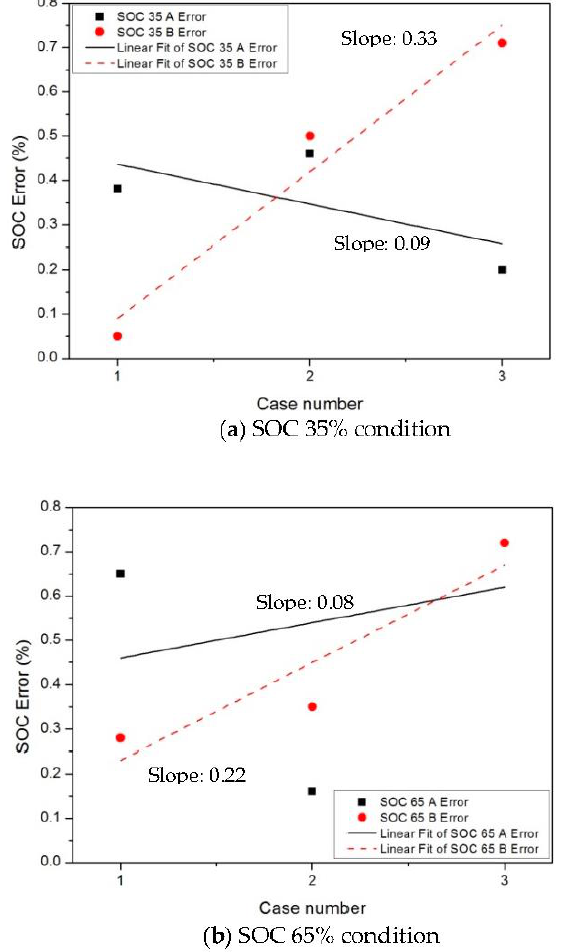
Figure 6. Linear fitting of error values between OBD data and PicoScope data.